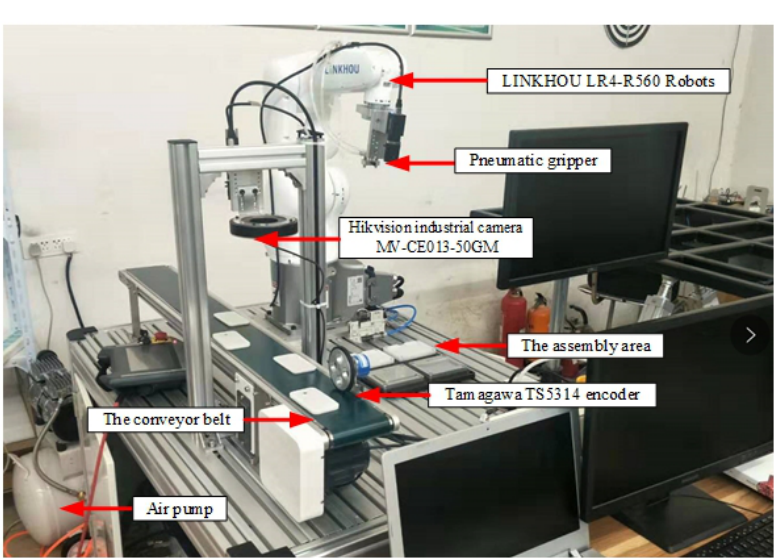
Figure 9. Platform of the dynamically grasping